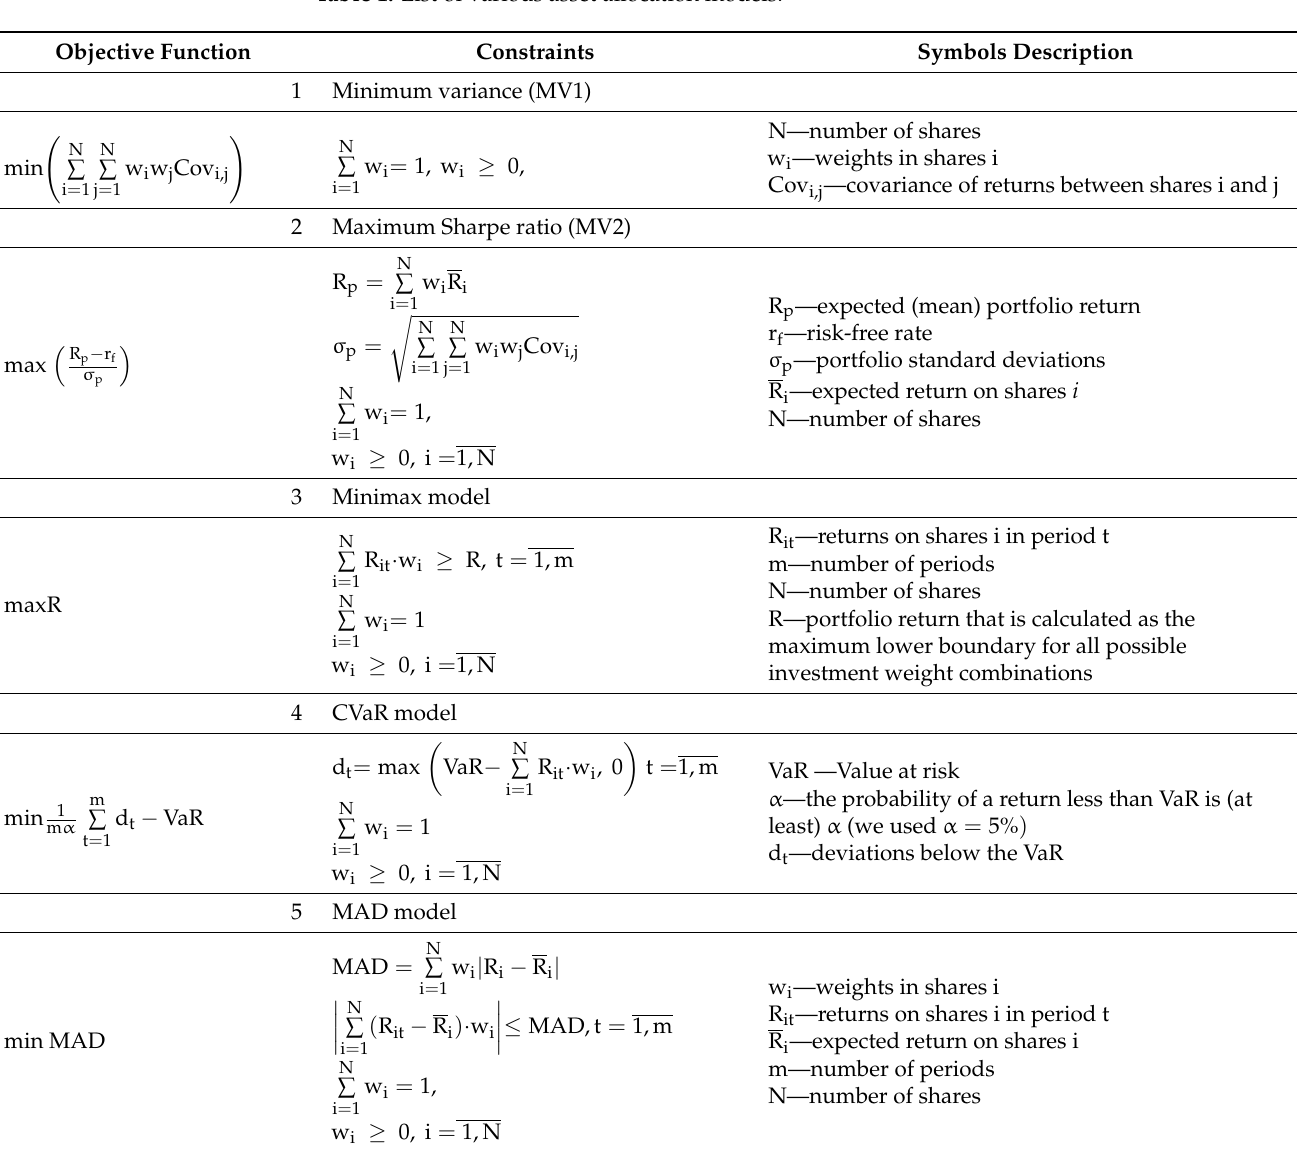
Table 1. List of various asset allocation